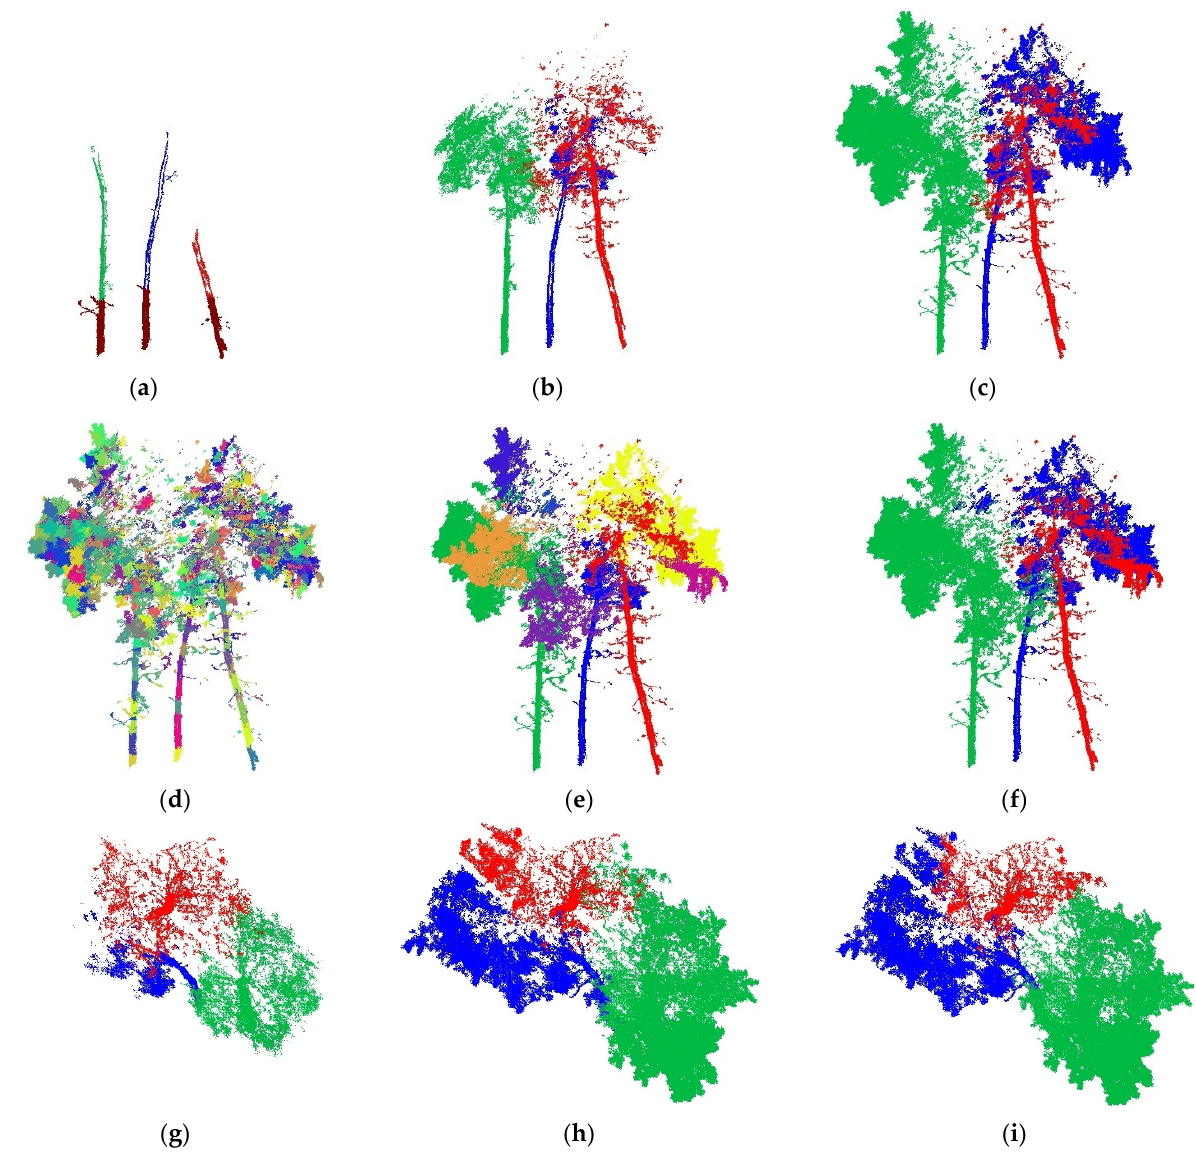
Figure 6. Intermediate output of treeseg and treeiso algorithms with three TAspen#1 tree point clouds as an example: ( a ) initial stem finding (in brown), and full-grown isolated stem (in red, green and blue, respectively) from treeseg ; ( b ) result isolated trees from treeseg ; ( c ) manually isolated reference trees; ( d ) initial clusters from first-stage segmentation of treeiso ; ( e ) merged segments from the second-stage segmentation of treeiso ; ( f ) result isolated trees from treeiso after global connection; ( g ) result treeseg trees from top view; ( h ) result treeiso trees from top view; and ( i ) reference trees from